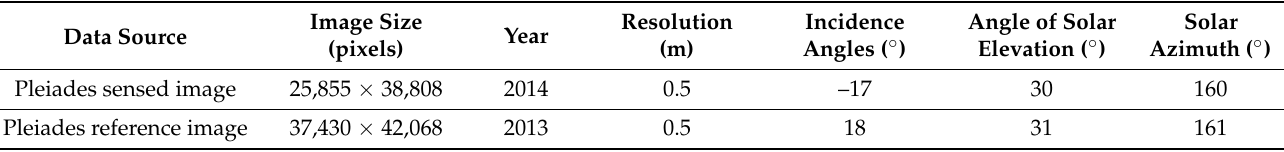
Table 1. Specific parameters of the Pleiades images.